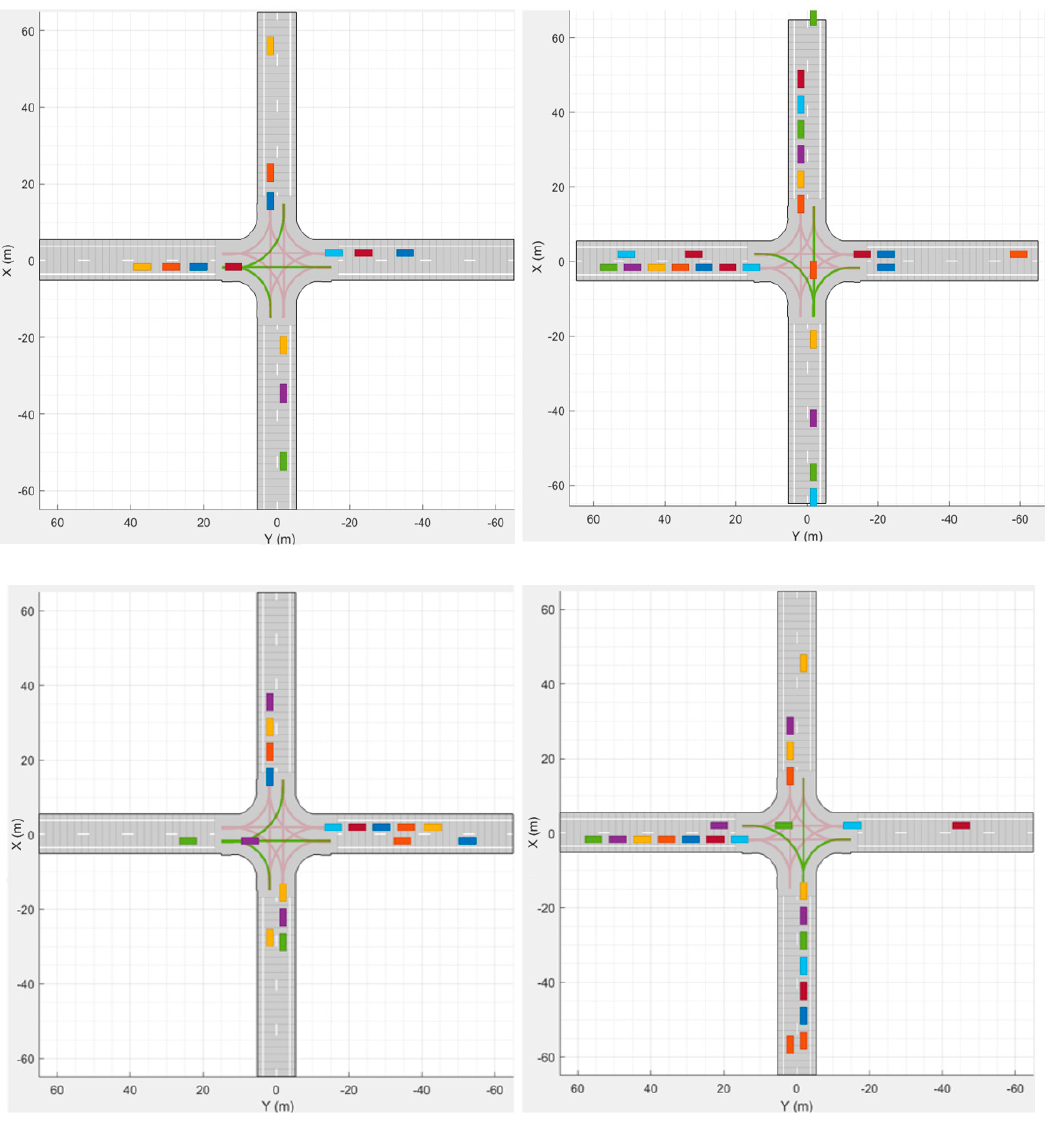
Figure 6. Sequences from the cars (the colored rectangles in the figures) traffic modeling of an intersection based on game theory implemented with intelligent multiagent.